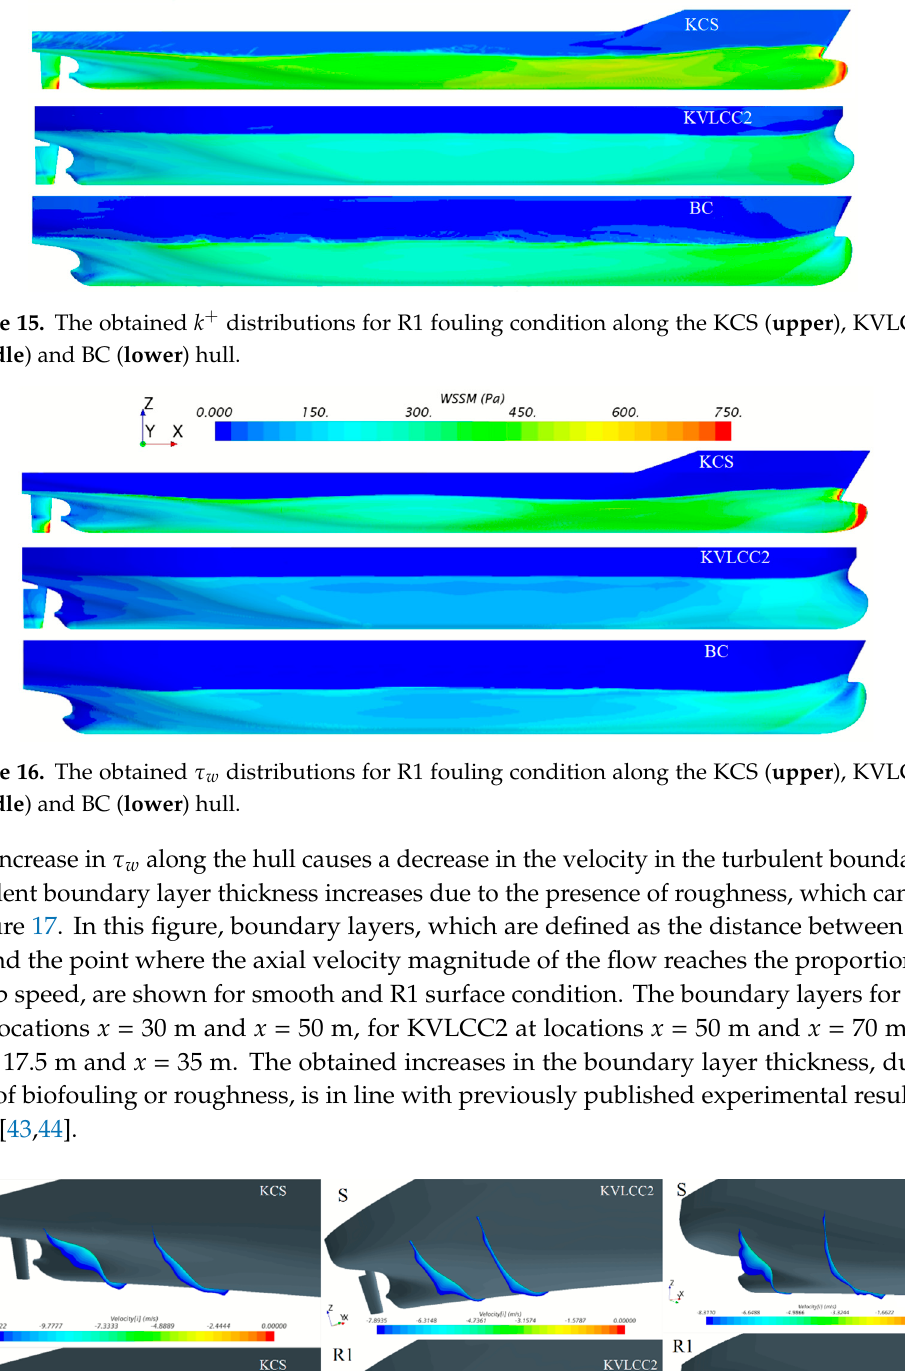
Figure 14. The obtained τ distributions for smooth surface condition along the KCS ( upper ), KVLCC2 ( middle ) and BC ( lower ) hull.